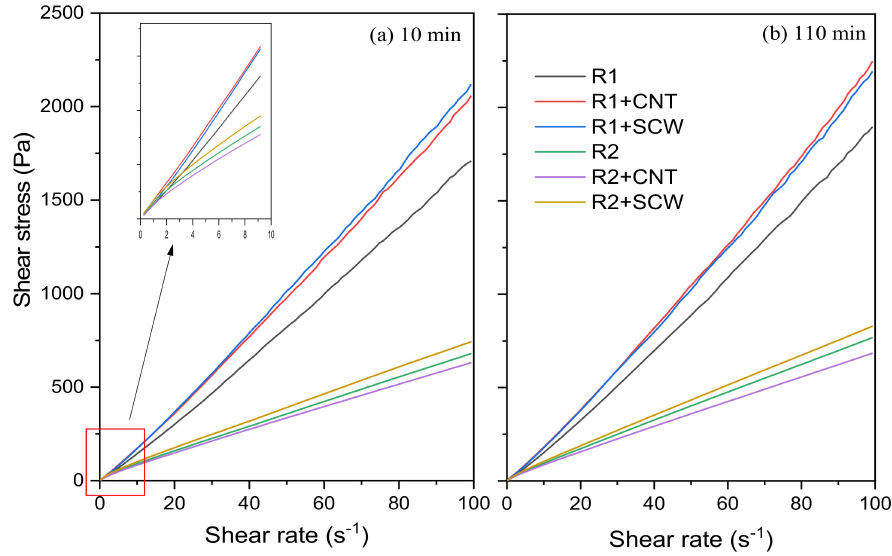
Figure 8. Shear stress of mixtures during: ( a ) 10 min; and ( b ) 110 min after contact between A.S and precursor.